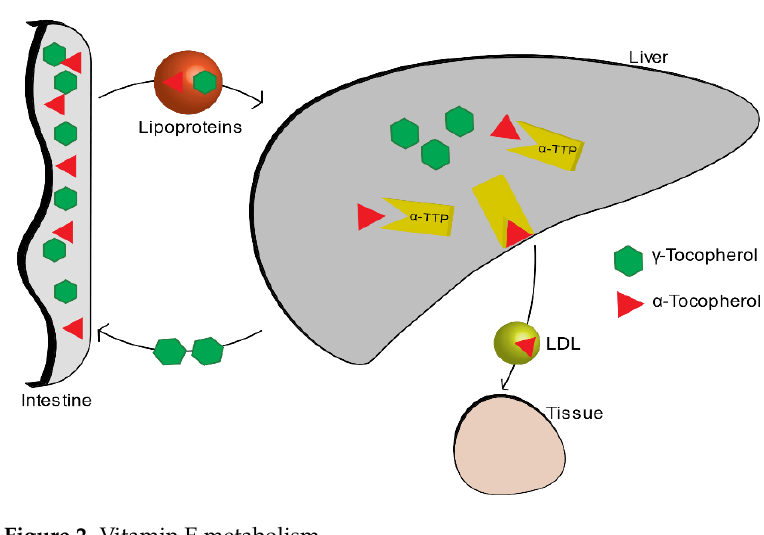
Figure 2. Vitamin E metabolism.